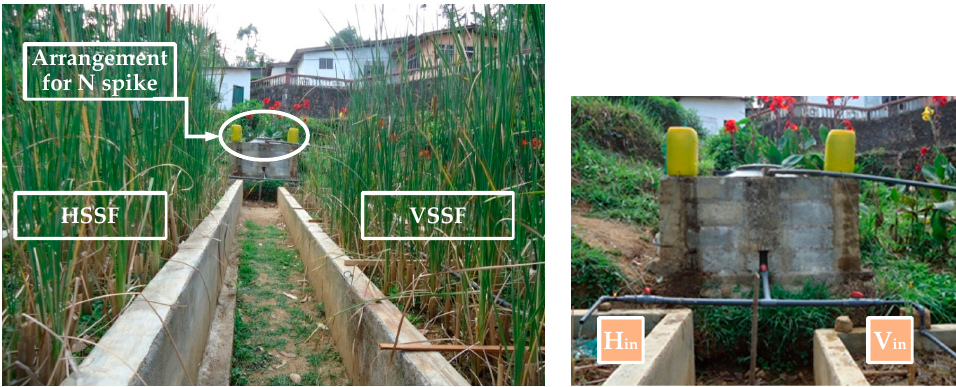
Figure 6. Arrangement for nitrogen (N) supplementation to the wetland units, H in : Influent to the HSSF unit and V in : Influent to the VSSF unit.